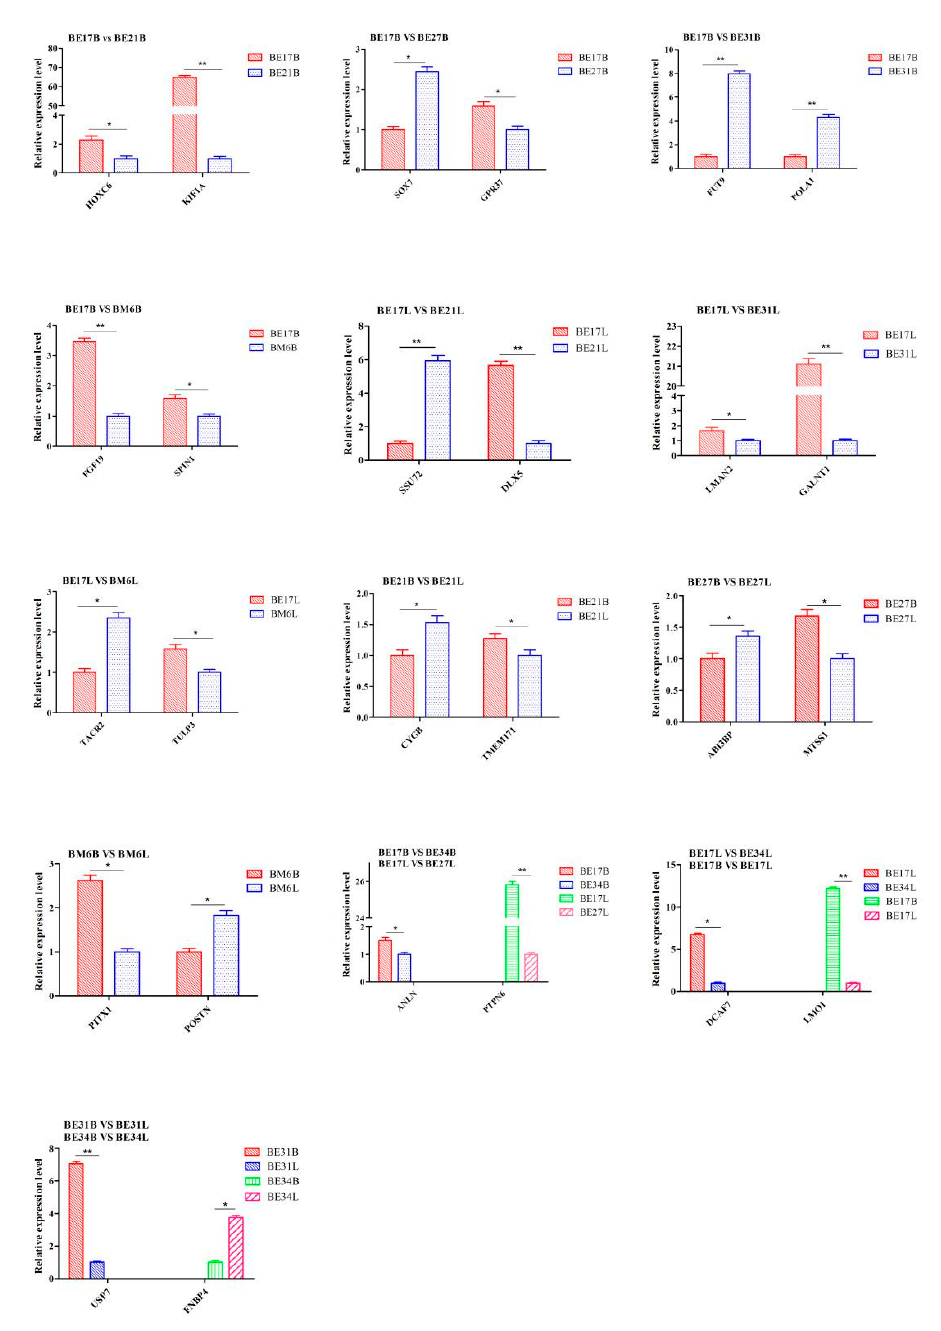
Figure 21. qPCR verification of DEGs. “*” was considered significant difference ( p < 0.05); “**” was considered extremely significant difference ( p > 0.01).